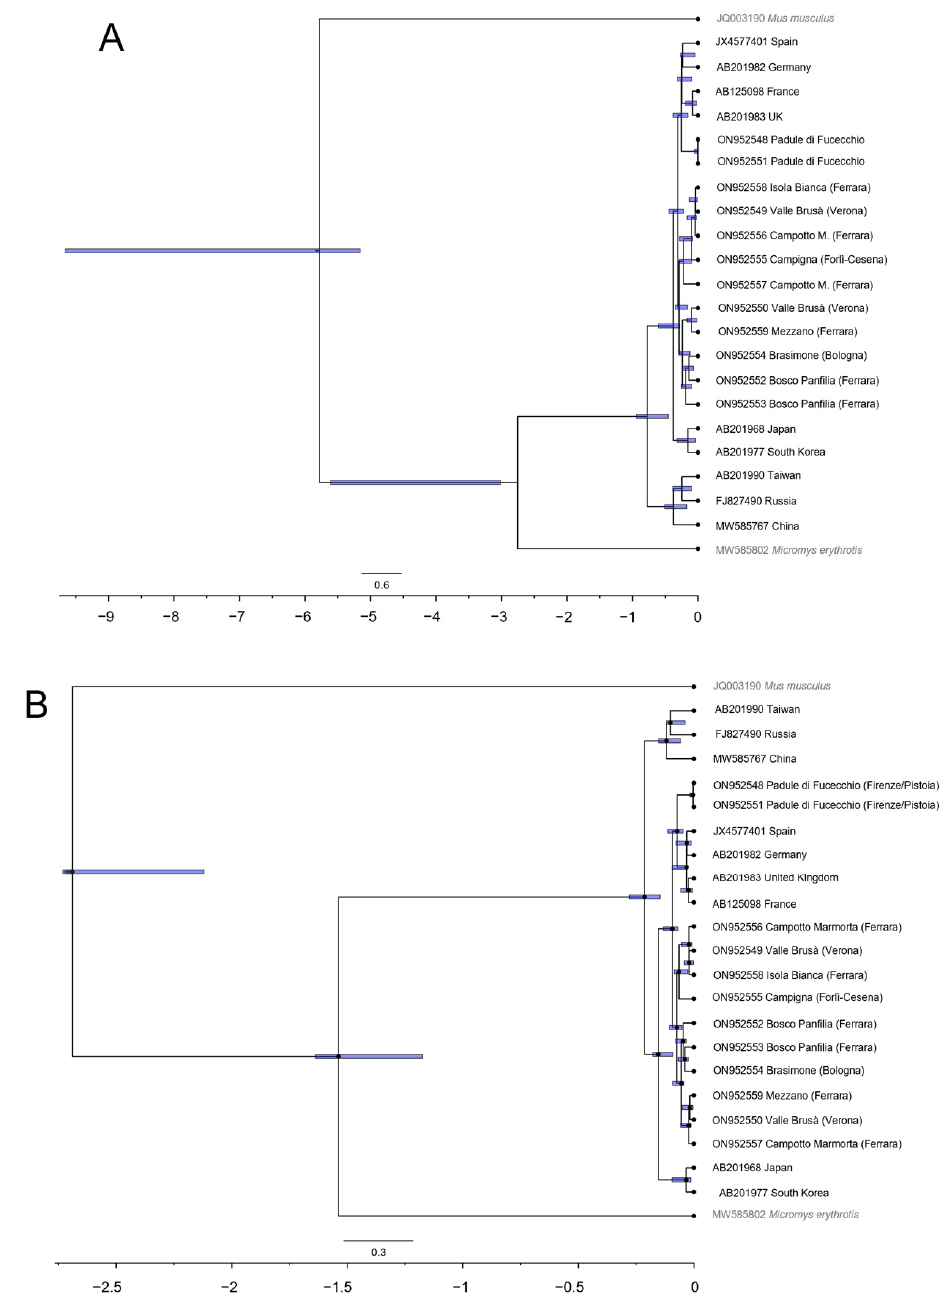
Figure 4. Divergence time chronograms of Micromys minutus using an uncorrelated relaxed clock method by BEAST and two rates estimated for rodents (( A ): 1.60%; ( B ): 9.75%). Branches are proportional to time in millions of years. Blue bars indicate 95% confidence intervals for the ages of basal branches in the tree and major lineages.